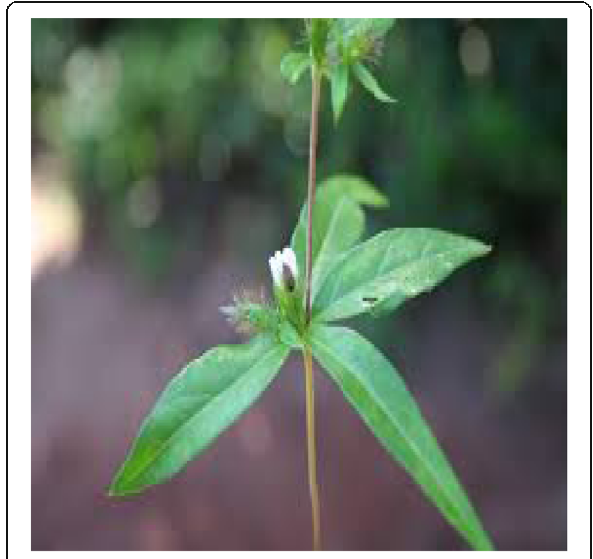
Fig. 1 Blepharis maderaspatensis . This endangered species belongs to the plant family Acanthaceae (Copy source Jacob Thomas